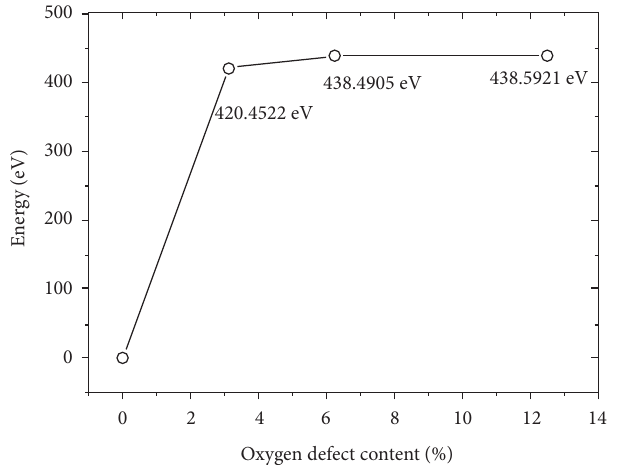
Figure 5: Normalized formation enthalpy E a function of oxygen defect